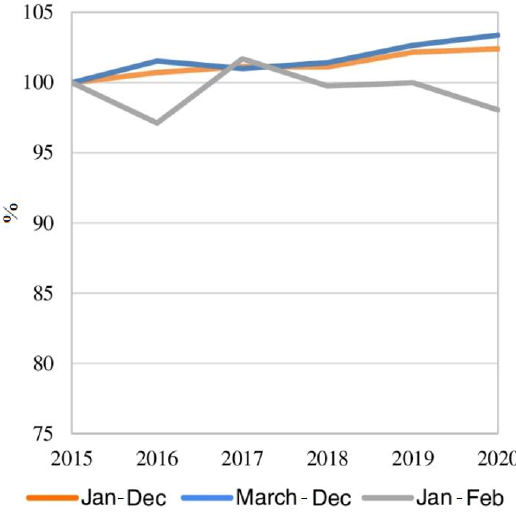
Figure 11. Development of alcohol consumption in Europe in recent years [59] .